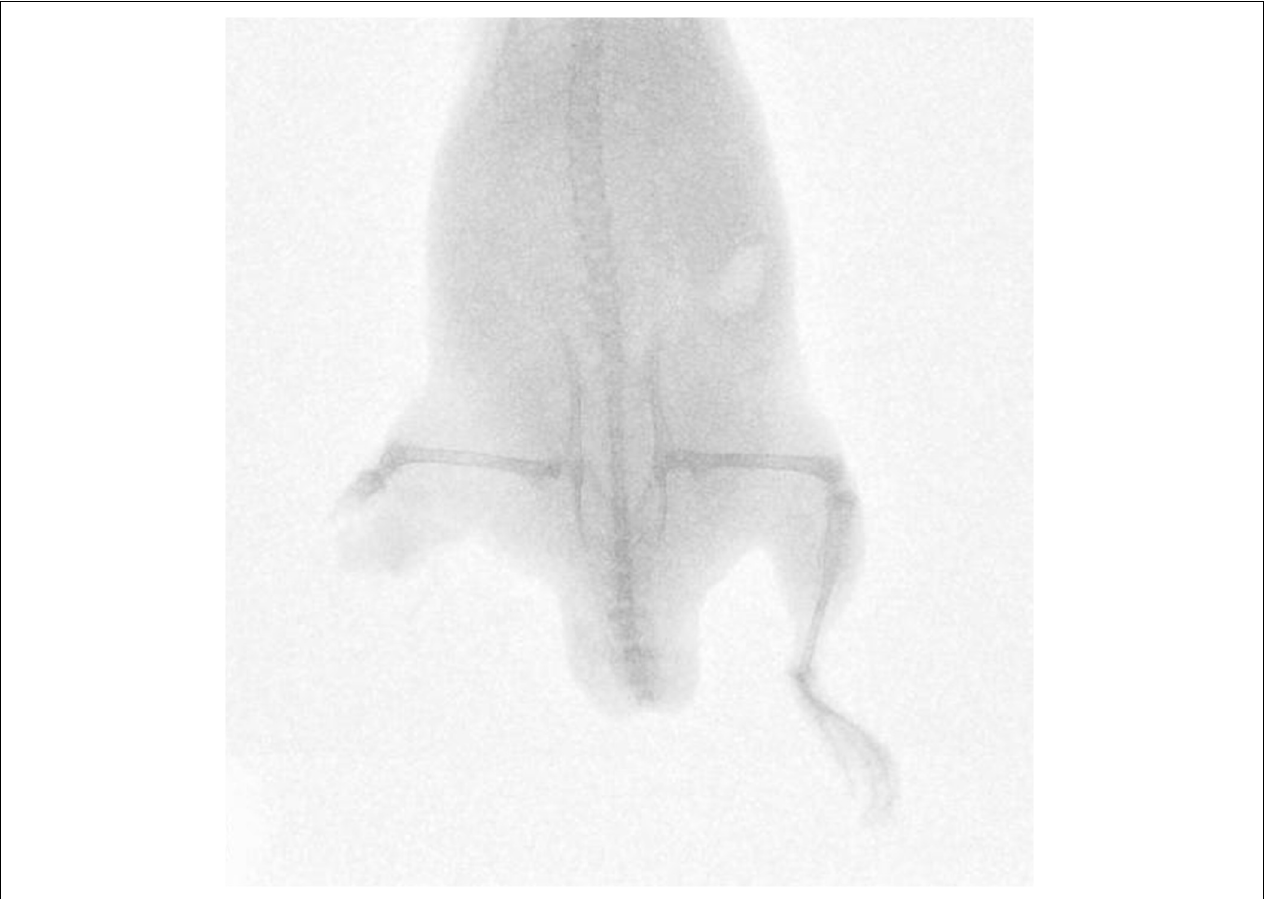
Images showing exemplar injuries sustained are shown in Figure 5 . These images show increasing severity of injury: initial skin lacerations and superficial wounding only (A), skin